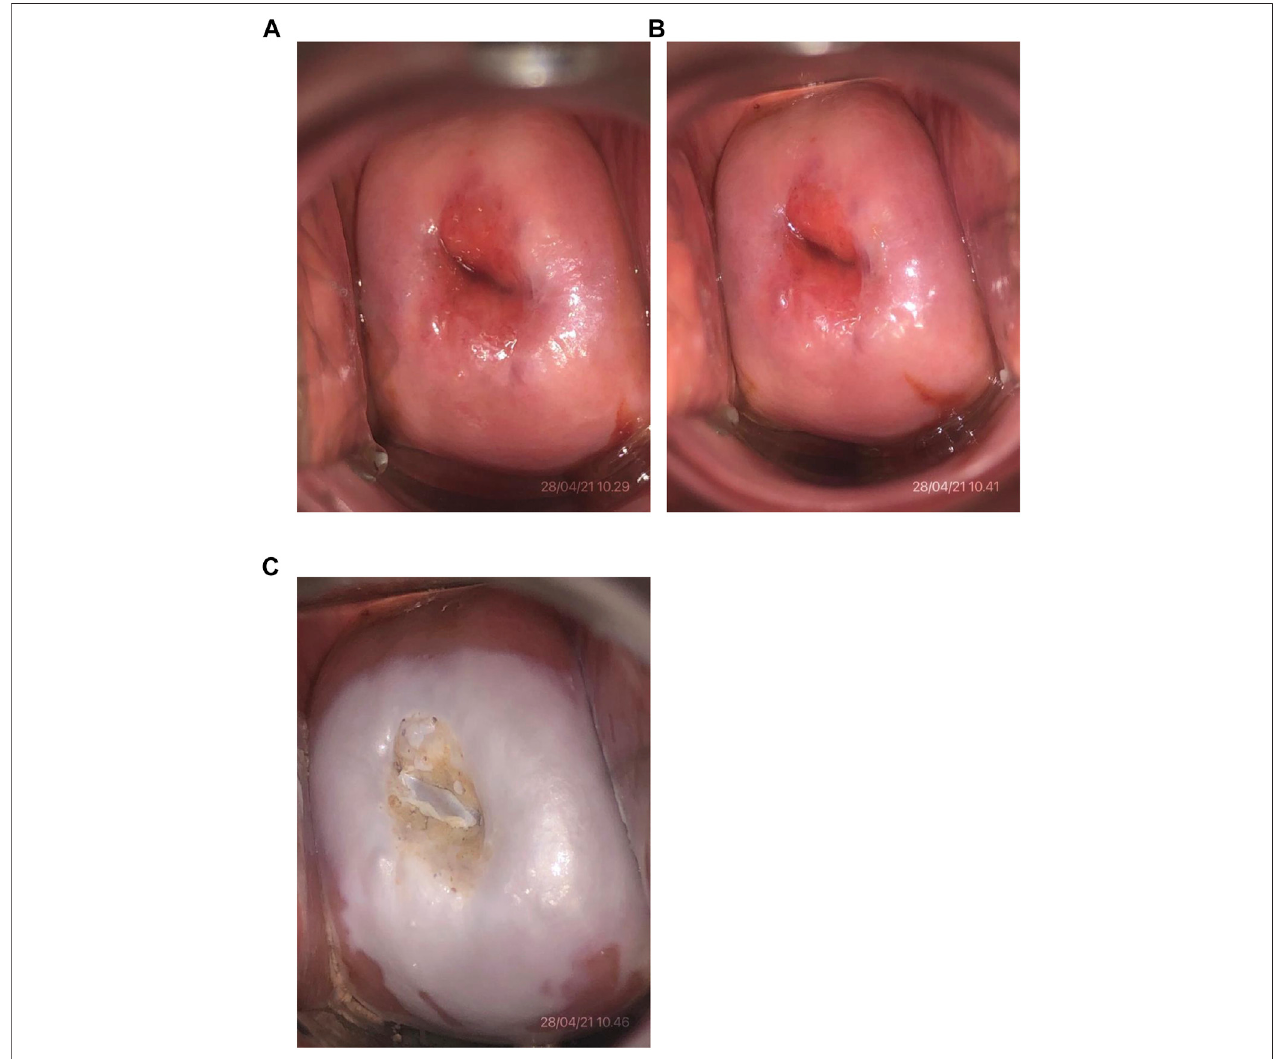
FIGURE2| Cervicalphotoafter85%TCAapplication. (A) Initialcervicalconditionofoneofthesubjects(No.4). (B) Conditionaftervisualinspectionwithaceticacid test with a negative result. (C) Condition after application of 85% TCA solution.